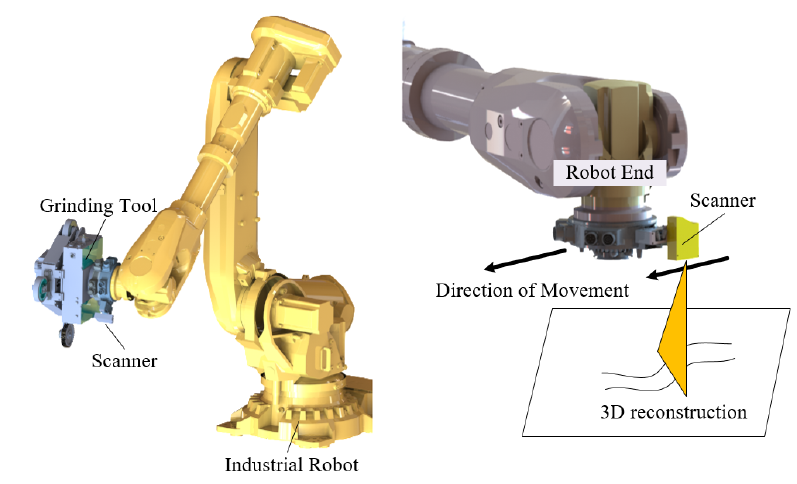
Figure 2. System working status and the grinding